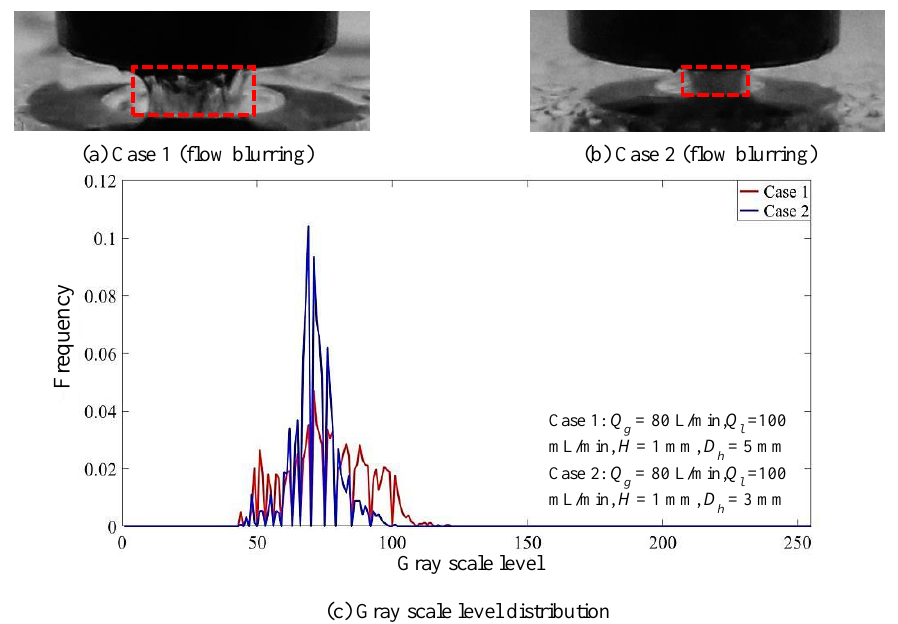
Figure 5. The experimental image with different mixing intensity and its gray distribution.